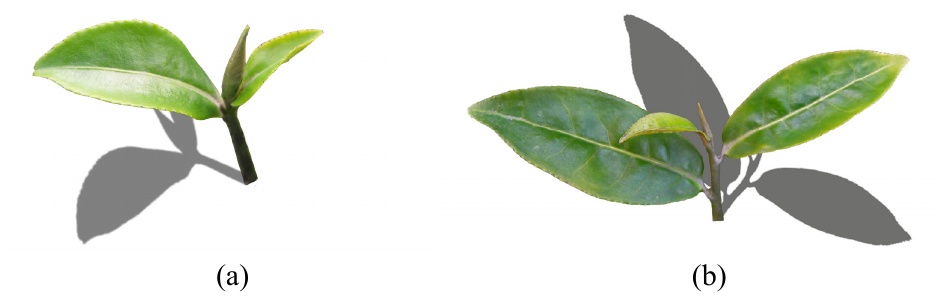
Figure 7. 3D modeling image (a) and simulation image (b) of